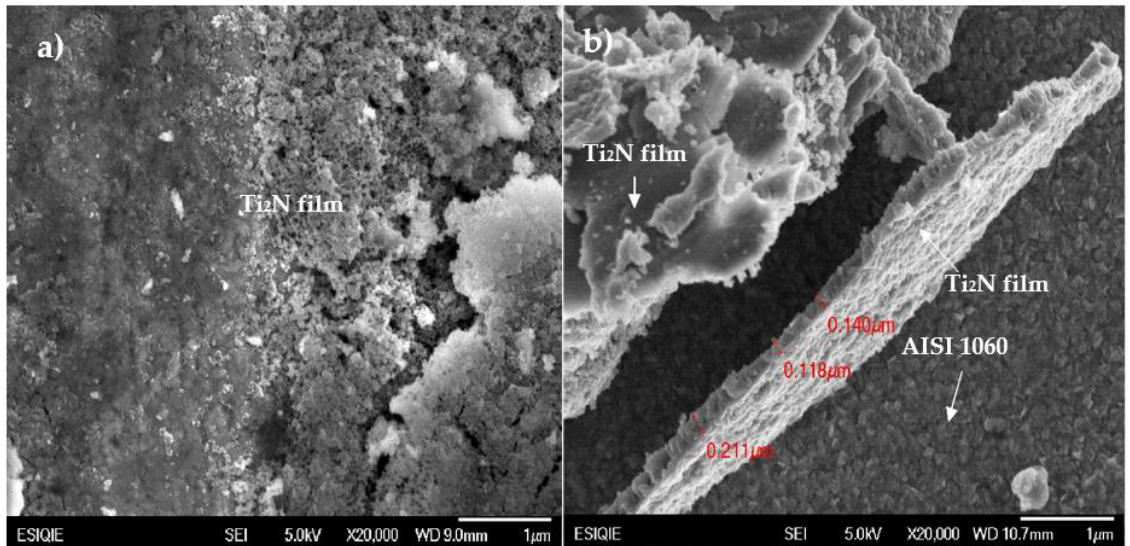
Figure 2. Top-view ( a ) and cross-section ( b ) trace scanning electron microscope (SEM) images of Ti/Ti 2 N films.